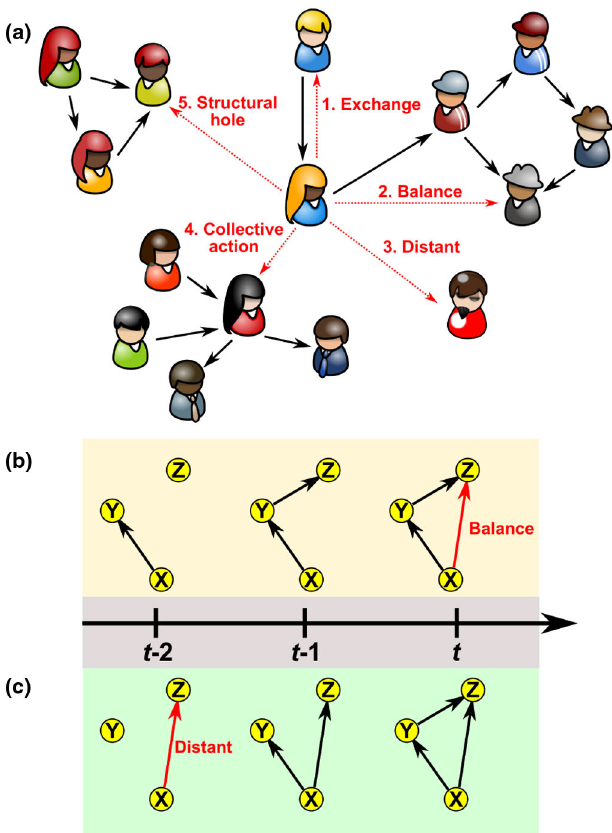
FIG. 1. (a) The five probabilistic tendencies we used to classify the interactions. Black arrows indicate existing links and red arrows are the possible options for a new link, according to the following tendencies: (1) social exchange, which corresponds to establishing a reciprocal link, i.e., add as favorite someone who has already added us to their favorites lists; (2) balance, where we select a favorite who is in the list of one of our existing favorites (friend of a friend); (3) distant connection, where the connection is to a member with whom there is no proximity, i.e., one needs at least three links to reach this member; (4) collective action, where we connect to a person whose connectivity is well above the average connectivity in the community (we quantify this behavior by examining whether the total degree of the receiving agent belongs to the upper 5% of the degree distribution at the given time); and (5) structural hole, where a link connects two otherwise not connected clusters of at least three members each, and which are otherwise not directly linked to each other (in the picture this link would connect the cluster of people in hats with the red- haired cluster). (b),(c) Why we cannot extract tendencies from a static snapshot: In the presented example a triangle relation is built from time t (cid:1) 2 to time t under two different scenarios that lead to the same resulting triangle. (b) The ties X-Y and Y-Z can be formed, at times t (cid:1) 2 and t (cid:1) 1 , respectively, via distant mechanisms resulting in a balance mechanism for the formation of X-Z at time t . Here X uses a friend of a friend to be introduced to Z. (c) A different path, though, would classify the X-Z tie differently. If X connects to Z before connecting to Y, then the X-Z link represents a distant tendency, since there are no close connections between them. A static network analysis would suggest that X used balance to connect to Z,